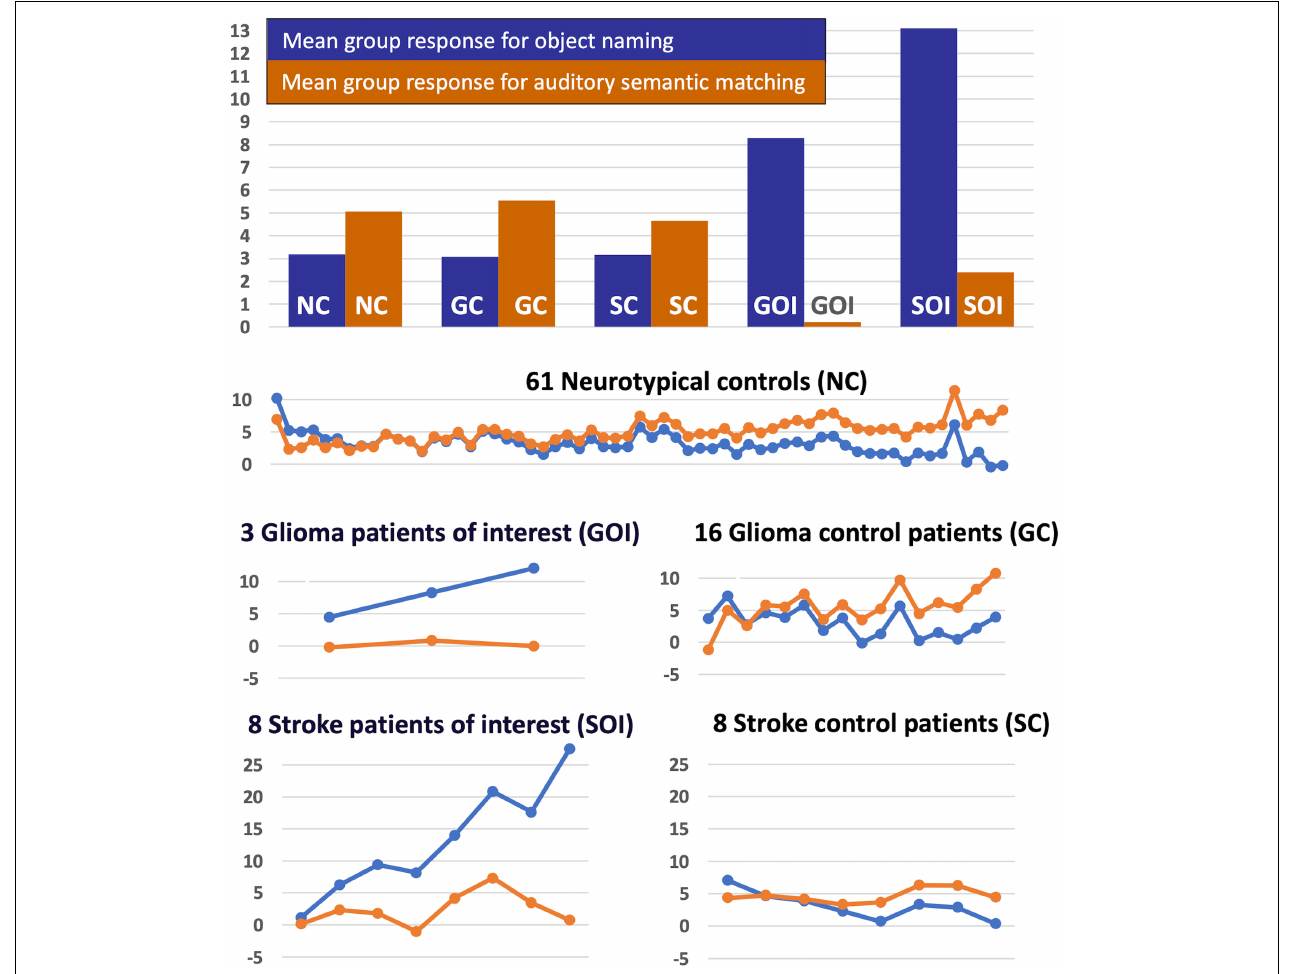
FIGURE 5 | Task-specific fMRI response in RpSTS [+51 − 25 +5]. The task-specific responses (blue = object naming, light brown = auditory semantic matching) in Right pSTS [+51 − 25 +5] are shown for the five groups of participants (NC, GC, SC, GOI, and SOI). The uppermost chart shows the mean group response for the two tasks for each of the five groups. The lower plots show the individual responses for the two tasks for each participant in each of the five groups (in total n = 96). Y-axis represent the fMRI responses (first eigenvariate extracted from